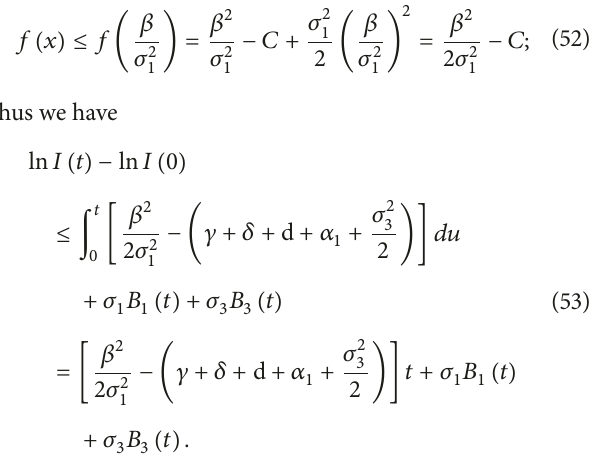
= 0.1; 𝜎 = 0.4; 𝜎 = 0.1; 𝜎 = 0.4; 𝜇 = 0.1 ; this way, 𝜎 2 1 1 2 3